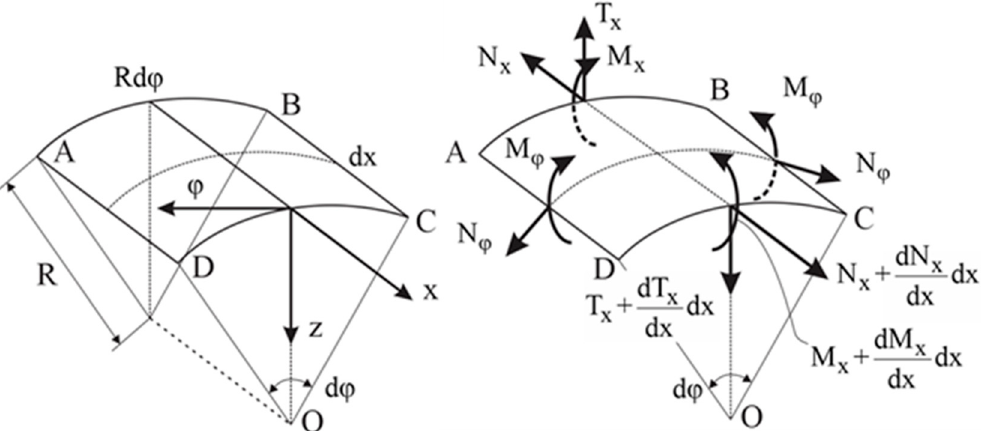
ϕ Figure 3. The scheme of an infinitesimal element of cylindrical plate: ϕ —the opening angle of the infinitesimal element; Figure 3. The scheme of an infinitesimal element of cylindrical plate: —the opening angle of R —radius of the infinitesimal element; N x —axial force; T x —normal force; M x , M ϕ —torsion torques; N ϕ —shear forces from N T the infinitesimal element; R —radius of the infinitesimal element; —axial force; —normal the median surface; T ϕ —shear forces normal to the median x x , M M N —shear forces from the median surface; T force; ϕ —torsion torques; ϕ ϕ —shear x forces normal to the median surface.